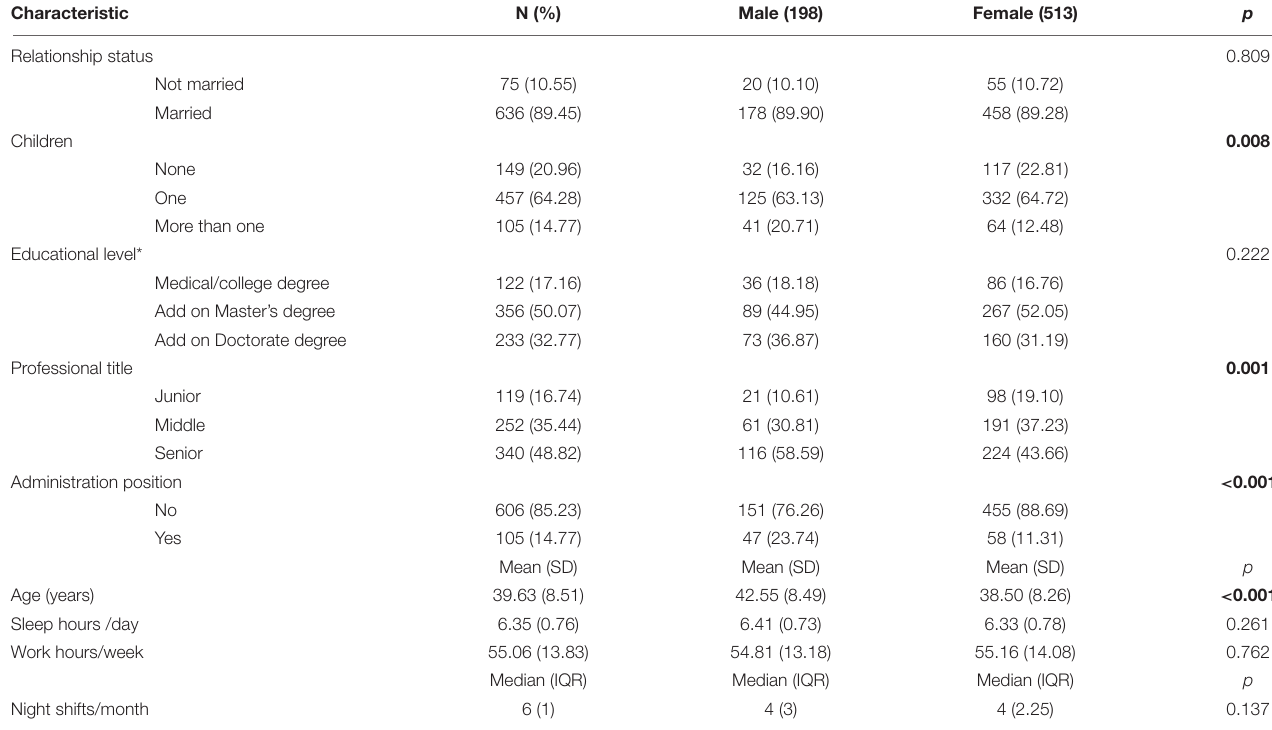
TABLE 1 | Basic Characteristics of 711 endocrinologists in